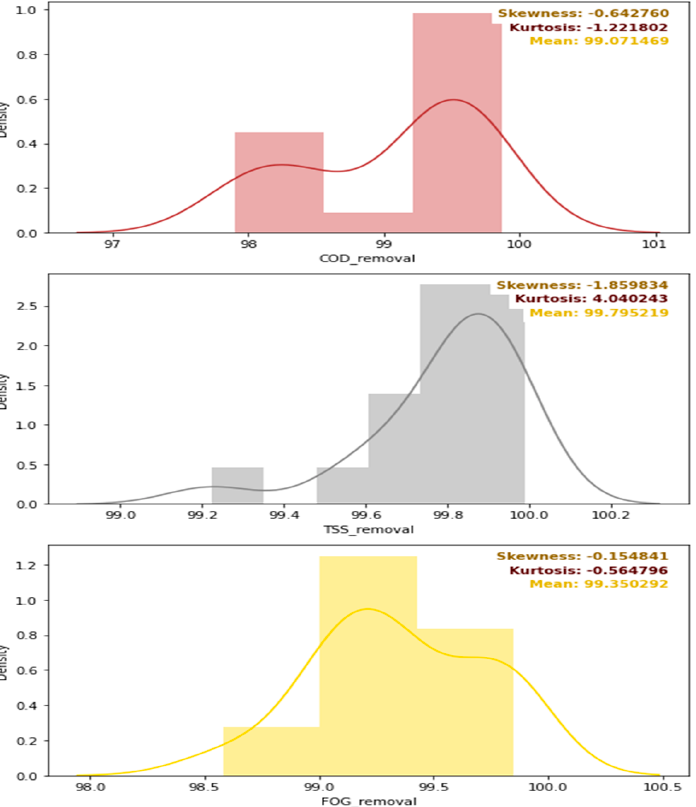
Figure 25. Density distribution, skewness, kurtosis, and mean values of the removal efficiencies of the combination of the pre-treatment stage, the DEGBR, and the MBR.